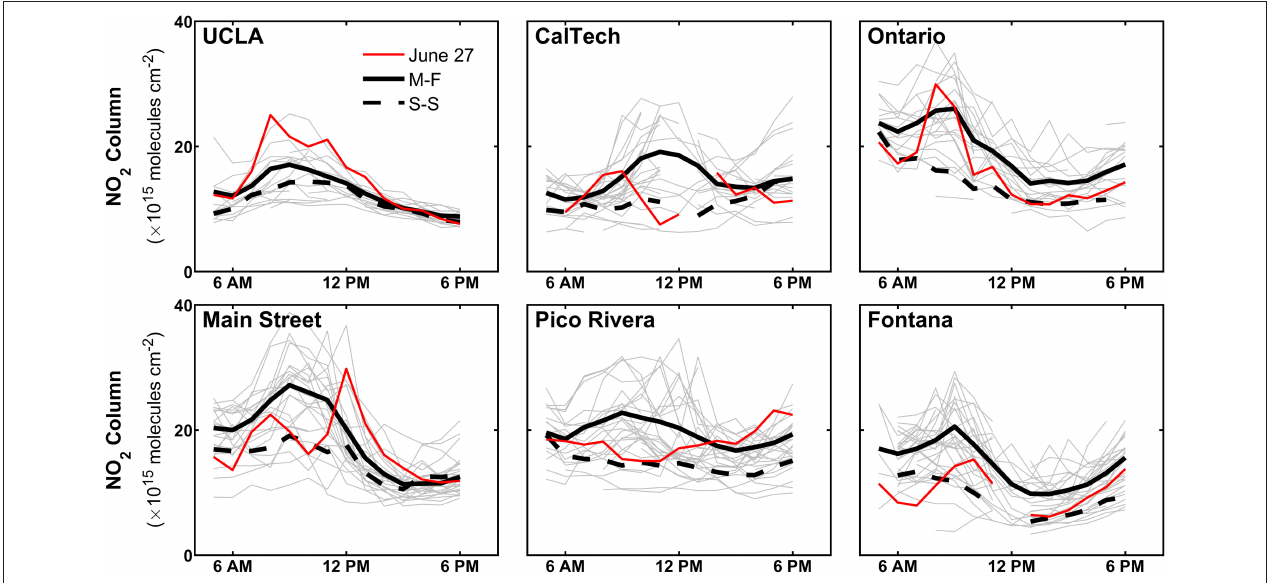
FIGURE 10 | Hourly averaged NO 2 vertical columns observed by ground-based Pandora spectrometers at UCLA, Los Angeles Main Street, CalTech, Pico Rivera, Ontario and Fontana. Gray lines are the individual day diurnal averages from June 15th through July 15th, 2017. June 27th, 2017 is overlaid in red, the weekday (Monday–Friday) averages are the black solid lines, and weekend (Saturday–Sunday) average observations are the black dashed